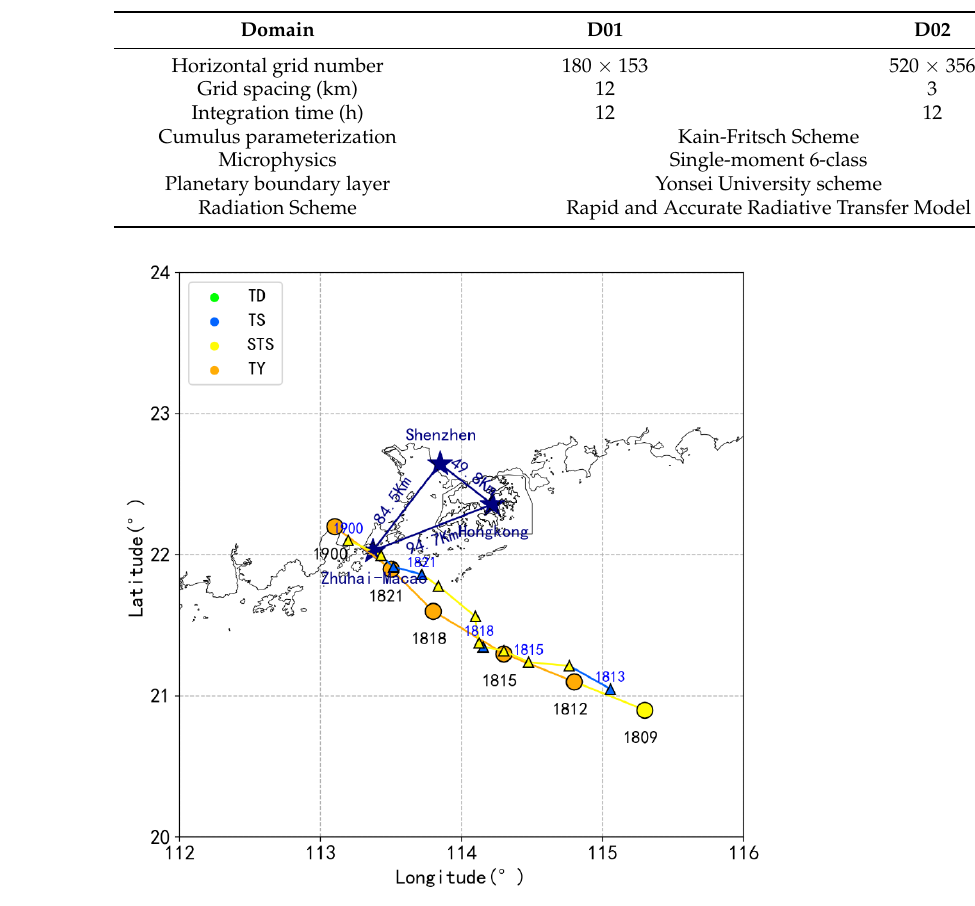
Table 2. Model configuration for the control experiment.